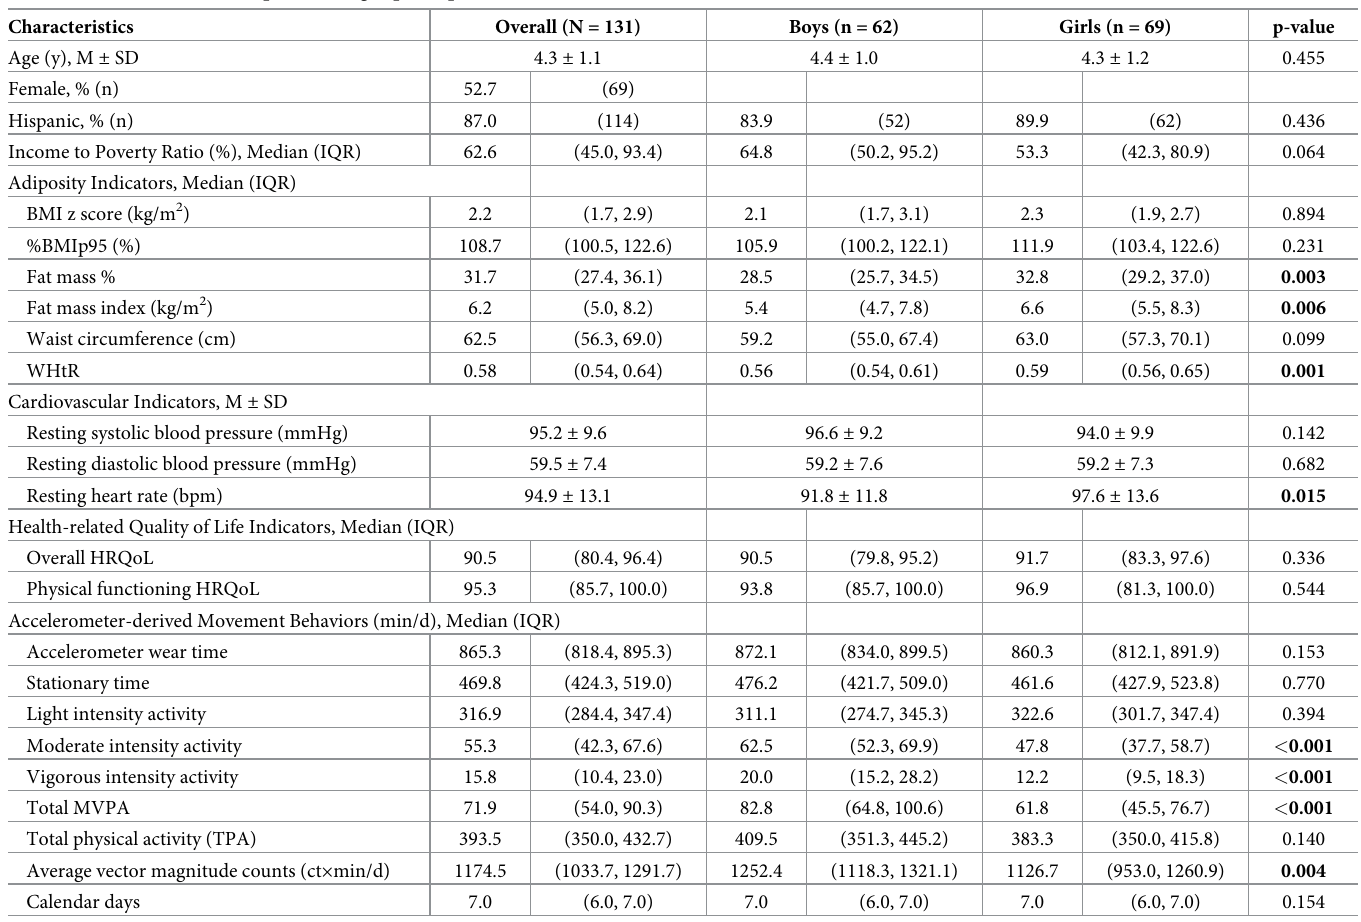
Table 1. Characteristics of the preschool-aged